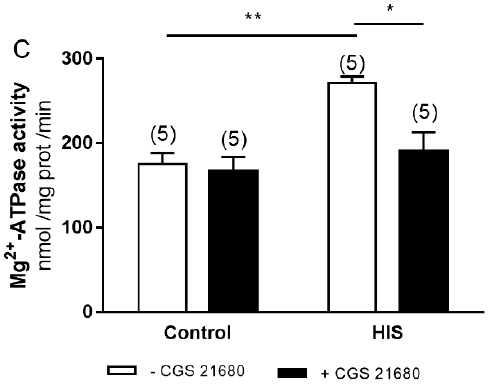
Figure 6. Effects of D 2 dopamine ( A ), adenosine A 1 ( B ) and A 2A receptors ( C ) activation on Mg 2+ - ATPase activity in neonatal cortex 5 days after HIS (PD 17). The activity of Mg 2+ -ATPase was measured in control rats (PD 17) and after HIS (PD 17), following the protocol described in the Materials and Methods section. To evaluate the influence of D 2 dopamine, adenosine A 1 and A 2A receptor activation on Na + /K + ATPase activity, the corresponding plasma membranes were preincubated for 6 min at 30 ◦ C with 140 µ M of sumanirole, 140 µ M of CPA and 140 µ M of CGS 21680, respectively. Each bar represents the mean ± SEM for n = 5 in all groups analyzed. * p < 0.05